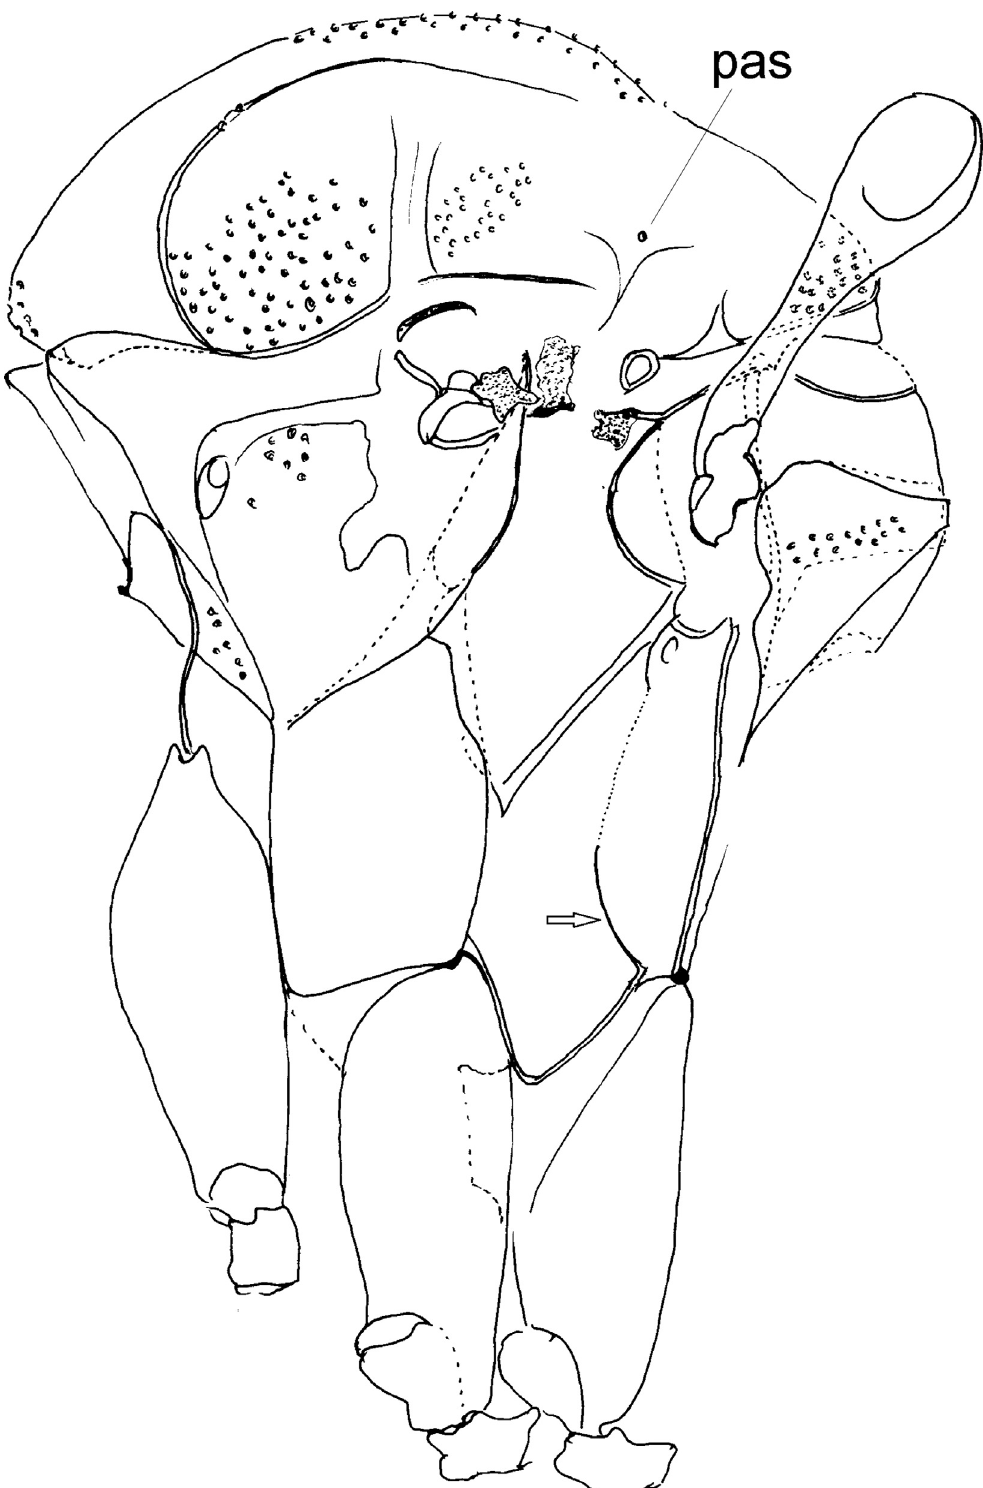
Figure 12. Thorax in lateral view of Phlebotominae with indication of characters in plesiomorphic state: arrow – indicating the long suture separating the katepimeron and metepisternum; pas – postalar seta. Oligodontomyia toroensis